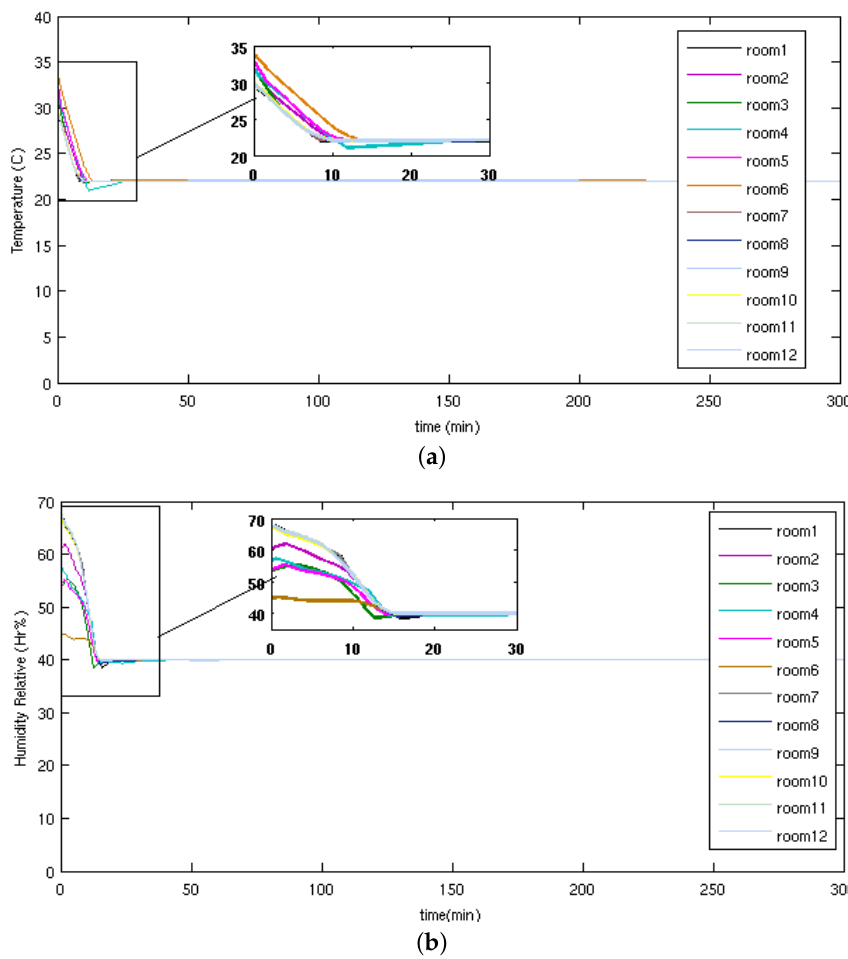
Figure 9. The simulation represents the temperature and humidity in each room in the presence of disturbances (20% packet loss). ( a ) Simulation results of the fuzzy control of room air temperature with temperature disturbances. ( b ) Simulation results of the fuzzy control of room air humidity with temperature disturbances. ( a , b ) The control of parallel multi-evaporator air-conditioning systems with IEEE 802.15.4 presents a high performance, achieving the robust practical response; it is possible to conclude that the fuzzy controller achieves the desired response, and the high gain controllers could be quite sensitive to